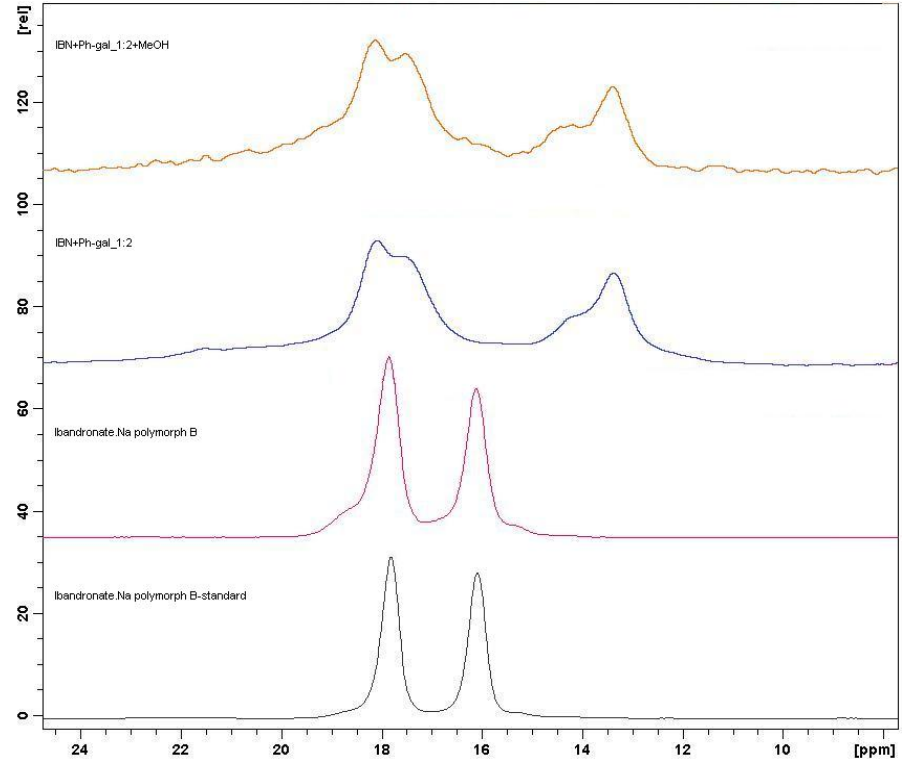
Figure 12. Comparison of 31 P CP/MAS NMR spectra of starting ibandronate monosodium salt form B and spectra of selected potential co-crystals (samples 2 and 6